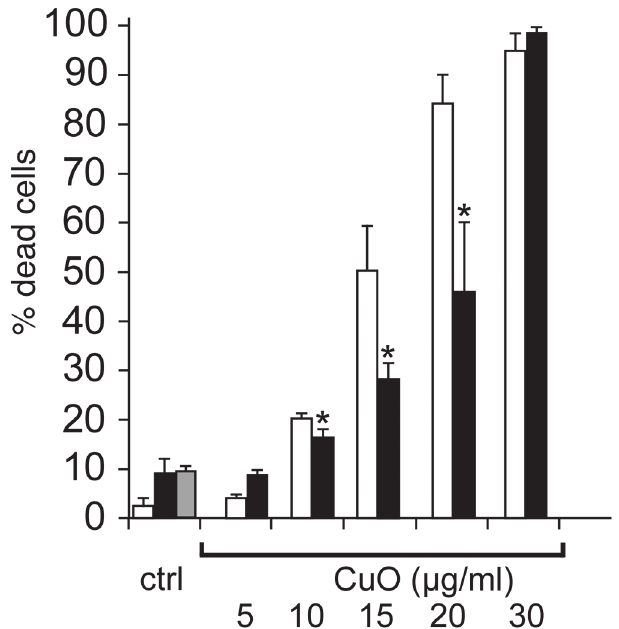
Fig 6. Importance of heme oxygenase induction in cell survival after treatment with copper. J774 cells were first treated with 2 μ M lovastatin for 6 hours (black bars) or with vehicle (white bars). Copper oxide nanoparticles were then added at the indicated concentrations for the remaining 18 hours prior to viability measurement. Experiments were carried out in quadruplicate. Statistical confidence (Student T-test) is indicated as follows: * : p (cid:1) 0.05; ** p (cid:1) 0.01; *** p (cid:1) 0.001.